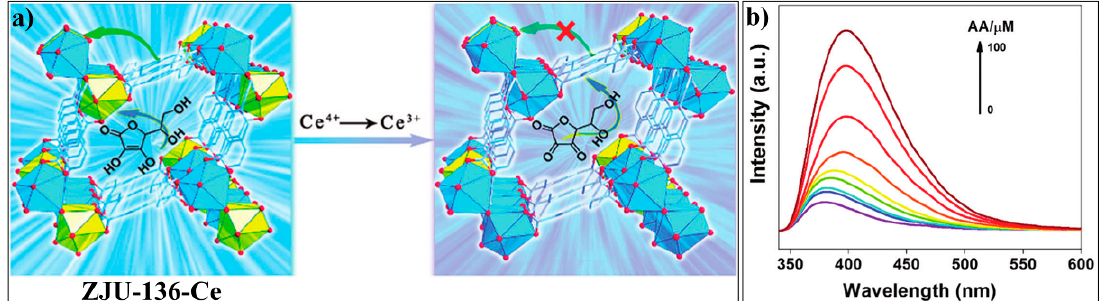
Figure 16. ( a ) Schematic illustration of the sensing mechanism of ZJU-136-Ce for asorbic acid (AA). ( b ) Luminescence spectra of ZJU-136-Ce in the presence of different concentrations of AA. Reproduced with permission from [121]. Copyright the Royal Society of Chemistry, 2017.